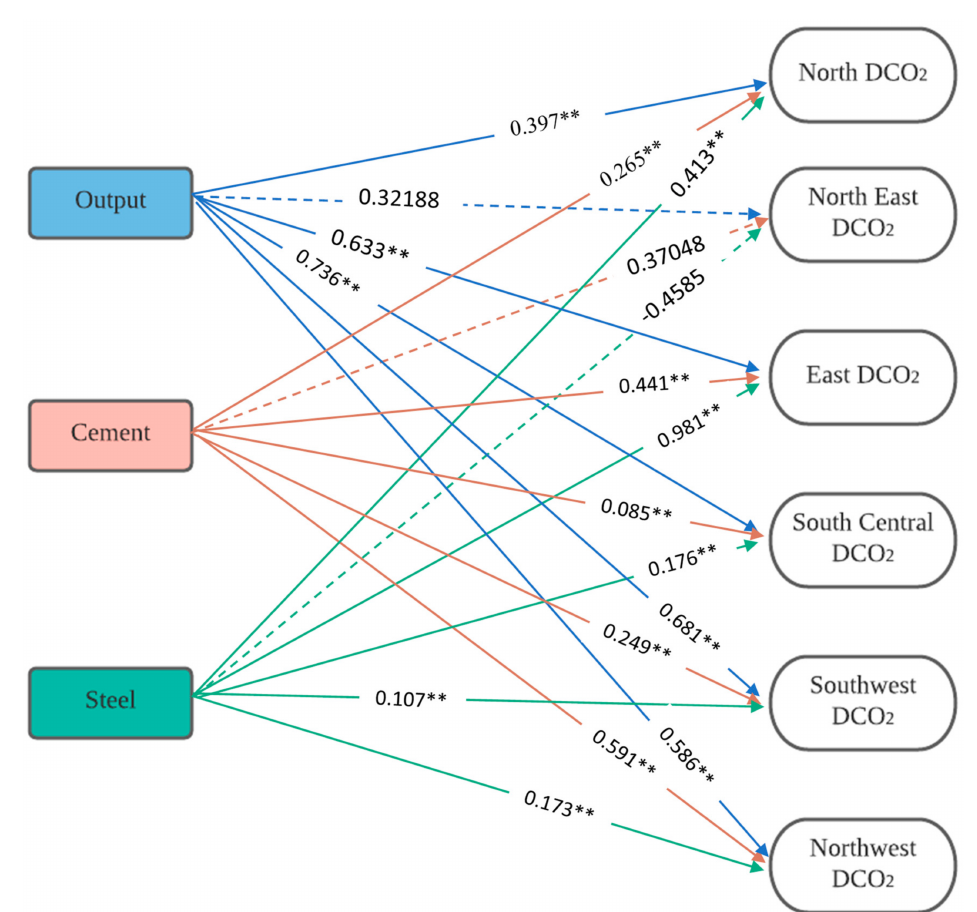
Figure 6. EcoF–RDCO2 direct CO 2 emission model in China’s construction sector. ** Correlation is significant at the 0.01 level